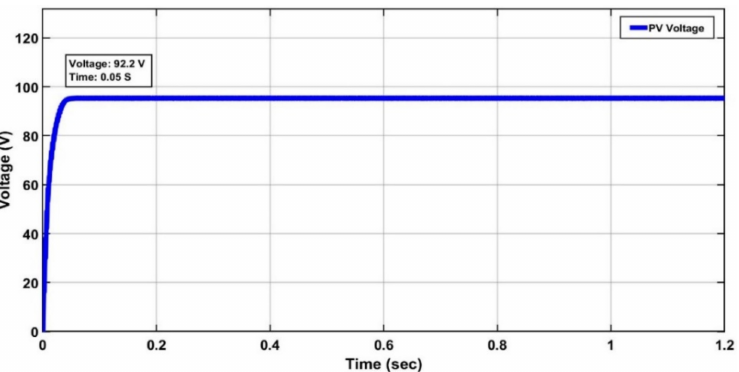
Figure 39. MPPT of Firefly Algorithm (Case-4).